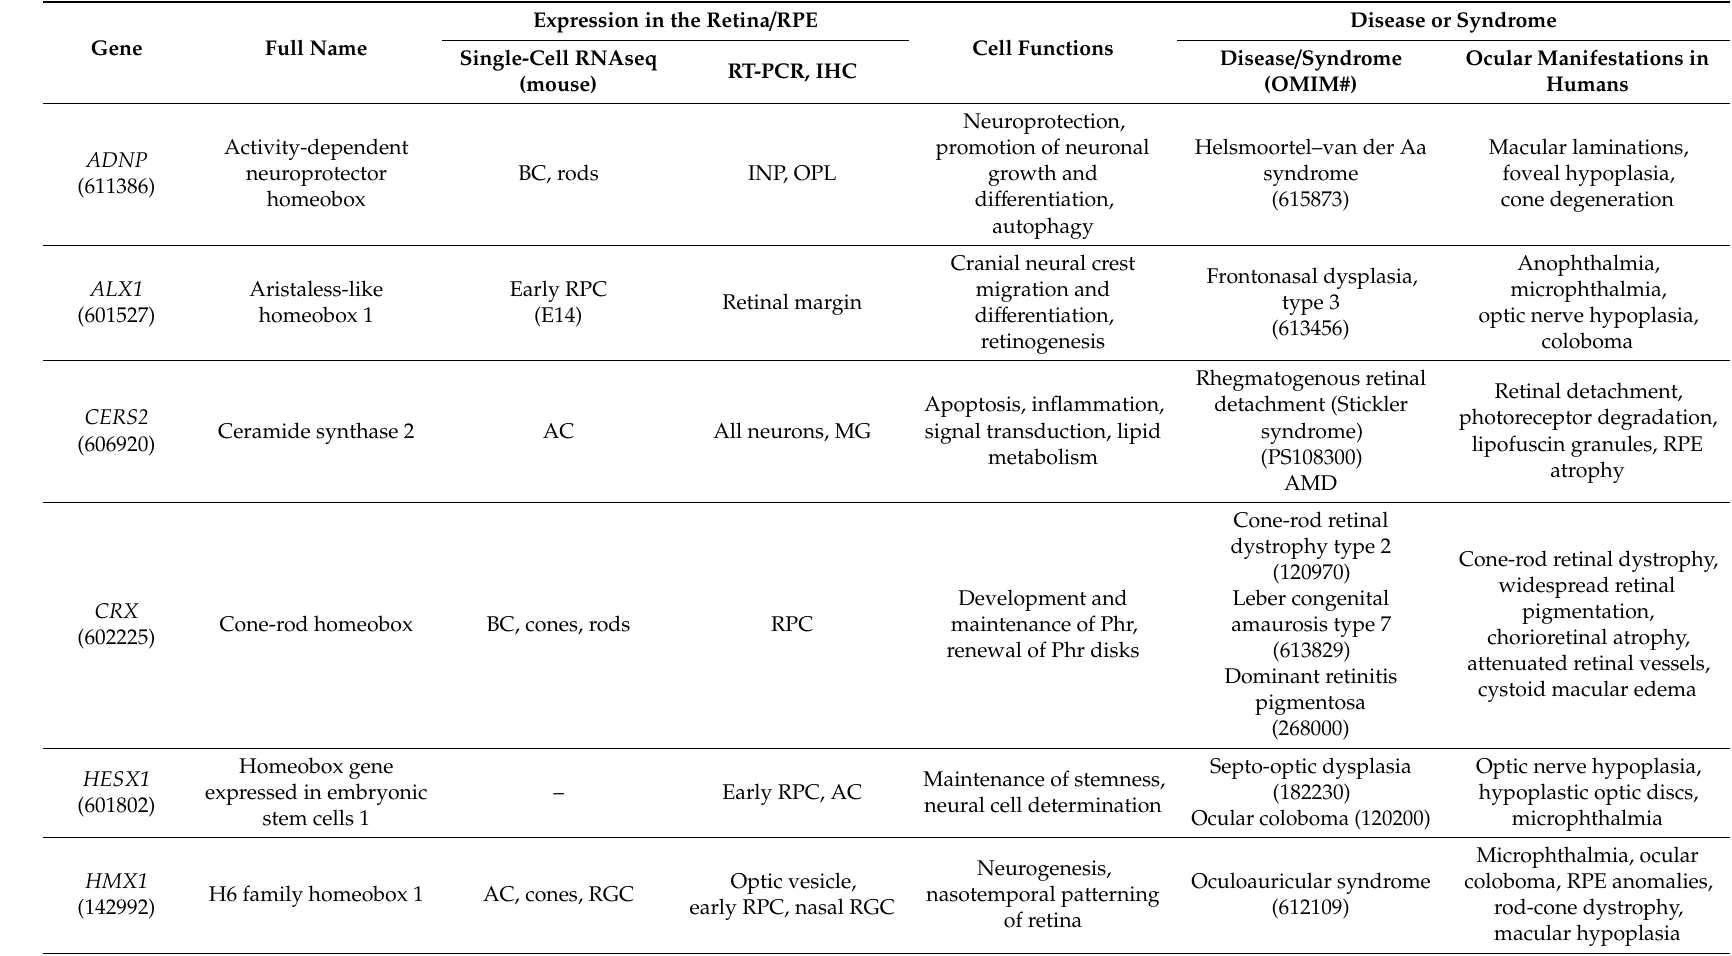
Table 2. Cell-type specificity and function of homeobox genes expressed in neural retina and associated with inherited eye diseases in humans.